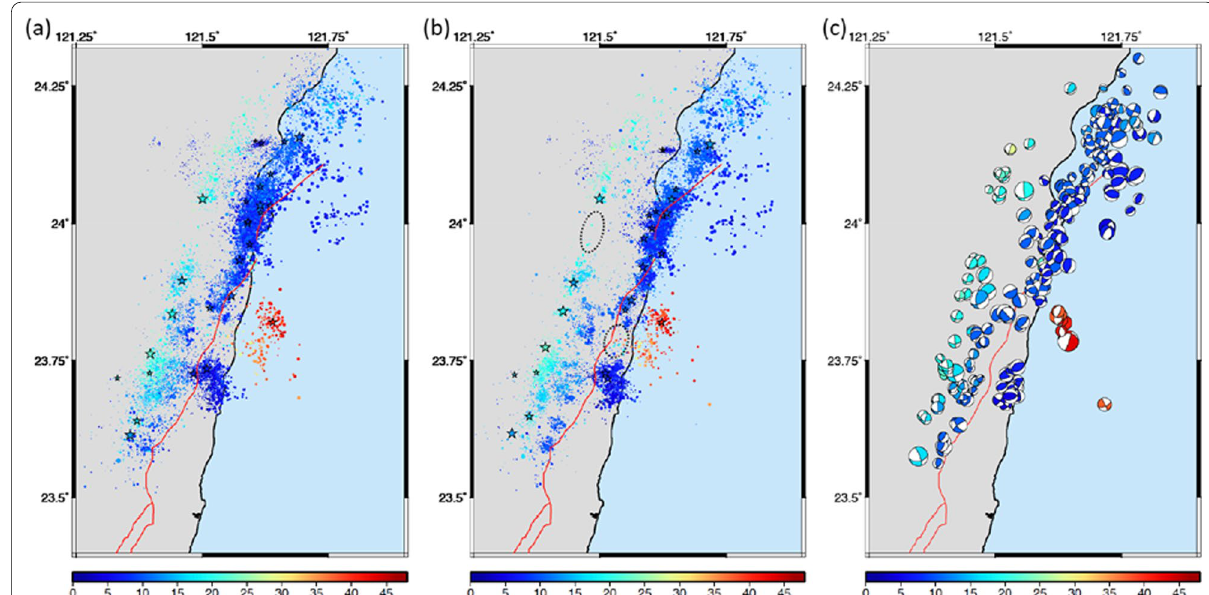
Fig. 4 Distribution of earthquake clusters before and after relocation and redetermined first‑motion focal mechanisms. a The epicenter of the seismic cluster from the original earthquake catalog. b The epicenter of the seismic cluster after 3D‑DD relocation. The black dashed circles indicate the fault segments remaining locked. c The first‑motion focal mechanism from this study. The color represents the focal depth (km) of these events